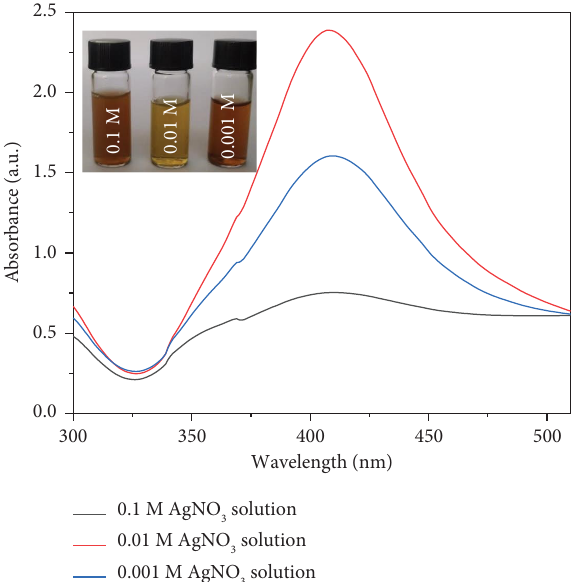
Figure 4: Determination of maximum Ag-NPs yielding potenti- ality employing diferent concentrations of ion source (AgNO 3 ) using UV-Vis spectroscopy and their color